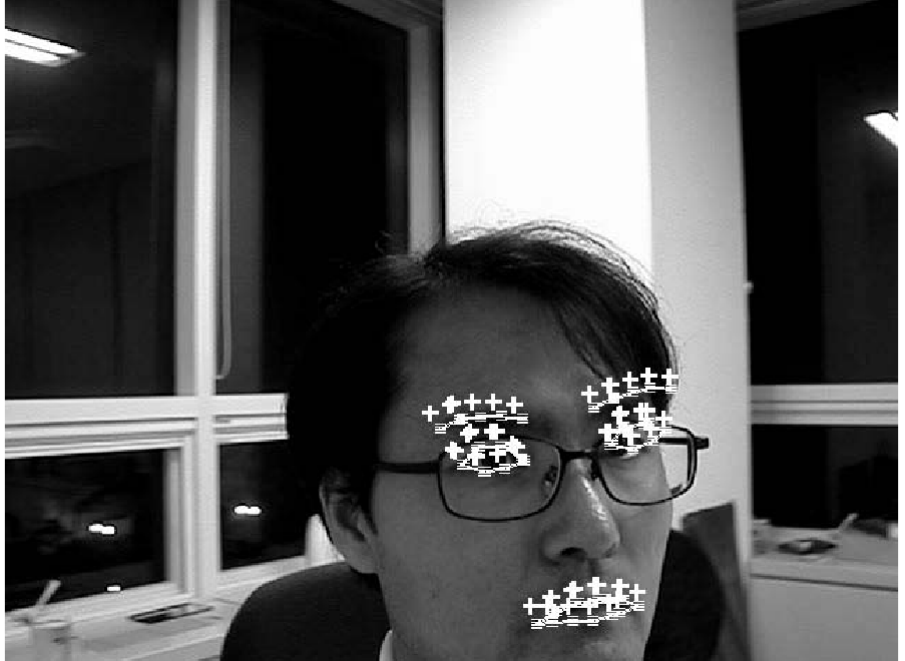
Figure 6. Conceptual comparison of the proposed method with contemporary methods. The leftmost picture is the given template. Areas to be used as indicators of comparison are marked with white highlight lines. In the target images given on the right, the area marked by the solid line (the proposed method) was deformed to match the target image, like the area marked by the triple line (brute-force method). On the other hand, the area indicated by the cross line (correlation method) was not deformed.